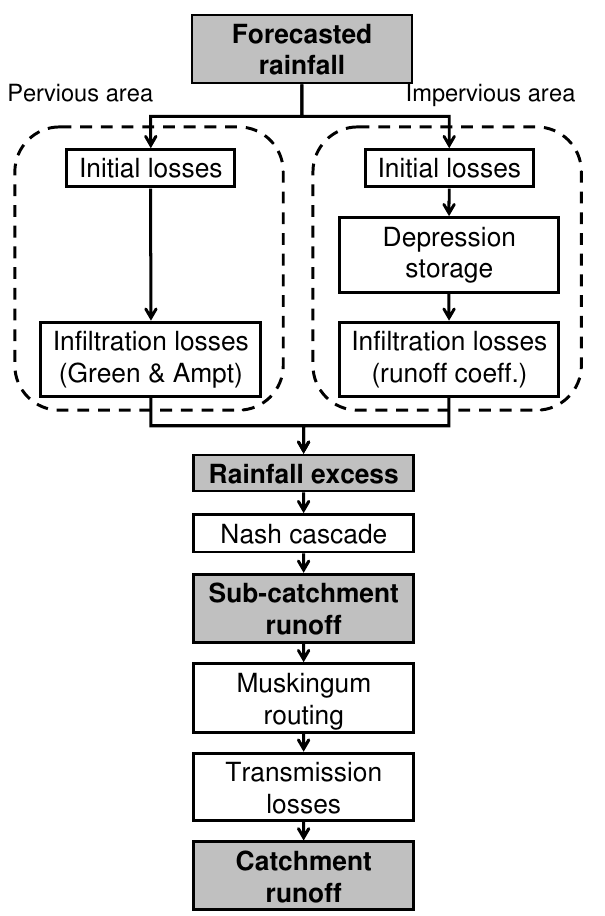
Fig. 6. Schematic view of the hydrological processes considered at the